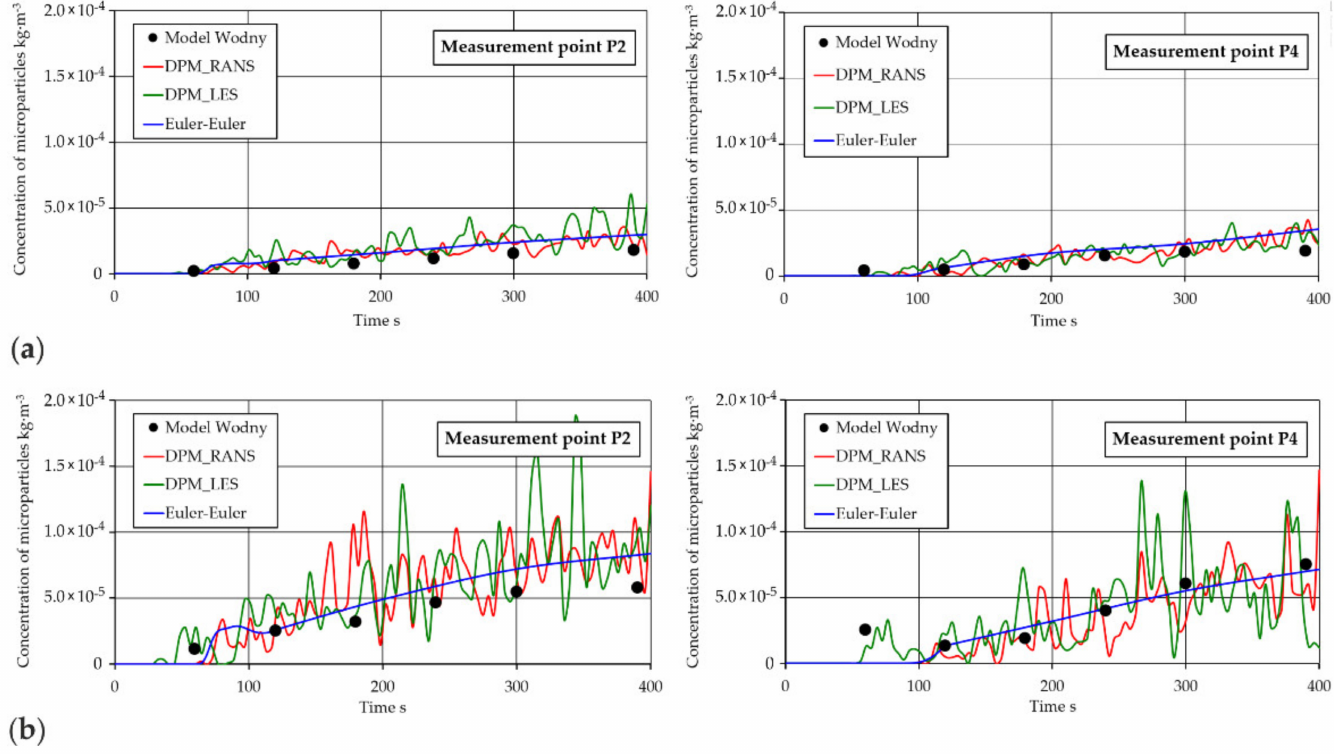
Figure 12. Concentration of microparticles at measuring points: ( a ) 20 µ m, ( b ) 50 µ